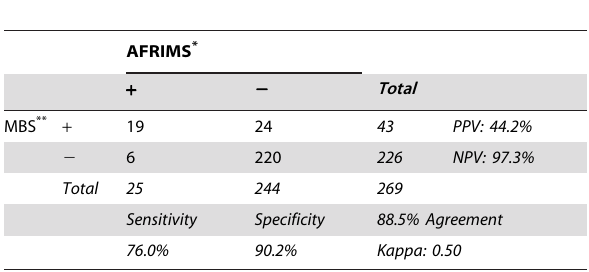
Table 2. Correlation between AFRIMS and commercial anti- HEV IgM